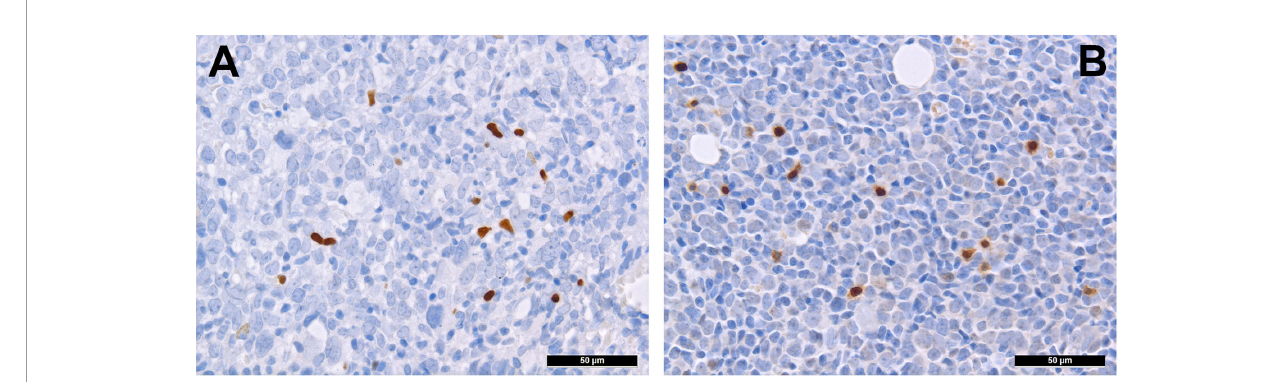
FIGURE 4 | Distribution of regulatory T-cells and TH1-cells in AML. Presence of regulatory T-cells expressing FOXP3 (A) and Tbet (B) in bone marrow involved by AML (immunohistochemistry, 400x).